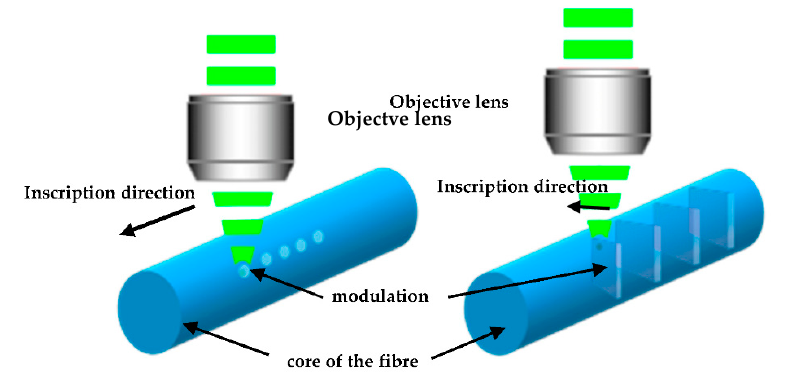
Figure 1. Schematic diagram of the refractive index modification according to the inscription method; ( left ) point-by-point and ( right ) plane-by-plane method.